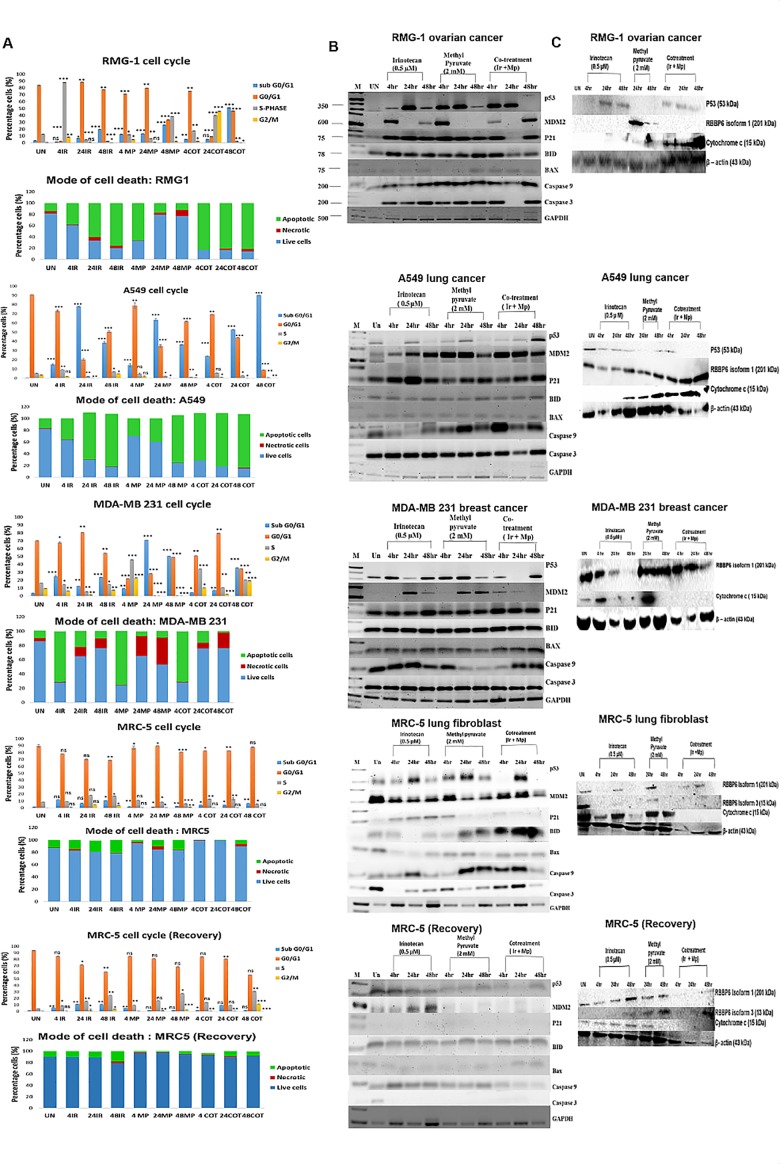
Exogenous pyruvate reduces irinotecan-induced apoptosis in normal cells while enhancing death of cancer cells.(a) representative FACS analyses showing cell cycle of RMG-1, A549, MDA-MB 231, and MRC-5 cell lines treated with 2 mM methyl pyruvate in the presence and absence of 0.5 μM irinotecan for 4, 24 and 48 hours respectively. (b) Depicts the mode of cell death for the various cell lines. Cells were stained with propidium iodide or with annexin V FITC assay. After treatment for these time periods MRC-5 cell were allowed to recover in fresh drug-free medium for a further 24 hours. The sub G0/G1 shift of cells was an indication of cell death (cells = less 2n DNA). All tests were conducted in three independent replicates. Experimental data were considered statistically significant when the p-value was ≤ 0.05 (p-value ≤ 0.001 (**) = very statistical significant, p-value ≤ 0.05 (*) = statistically significant and p-value ≥ 0.05 (ns) = not to be statistically significant). Detailed statistical data in S2 Table. Statistical analysis was done using the Graphpad software. COT: “cotreatment” indicating treatment with both irinotecan and methyl pyruvate, IR: irinotecan and Mp: methyl pyruvate. All data were acquired using the BD Accuri C6 flow cytometry.